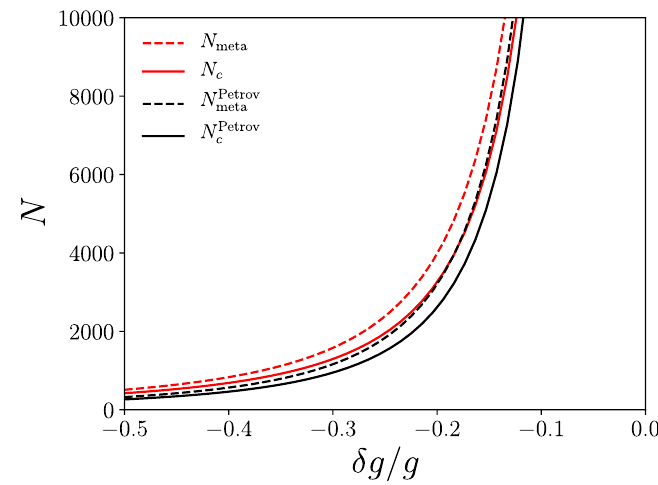
Figure 6: Critical number of atoms as a function of δ g / g . The solid and dashed lines are the predicted atom numbers for the unstable ( N droplet solution, respectively. The top red curves are evaluated within our theory, while the bottom black curves are calculated using the universal approach of Ref. [ 3 ] = 24.03 for the black dashed and ˜ N ( ˜ N meta